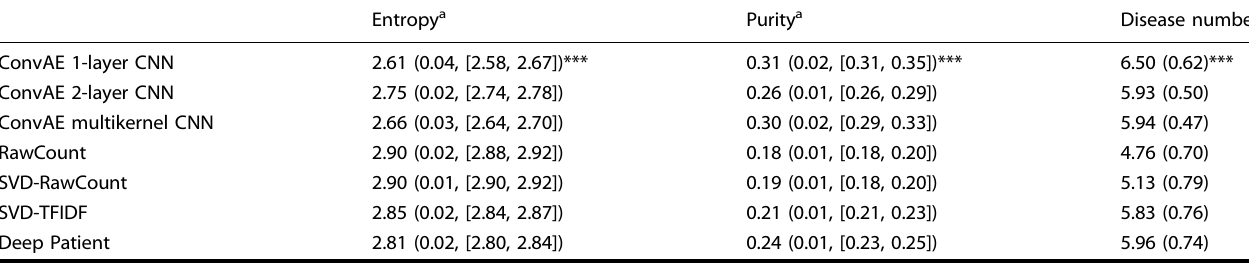
Table 1. Multi-disease clustering performances of ConvAE con fi gurations and